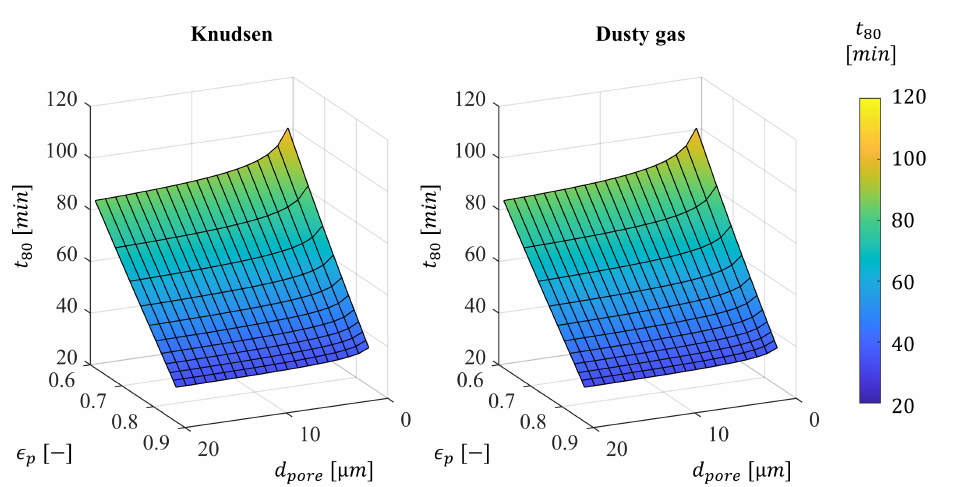
Figure 5. Primary drying time as a function of mean pore diameter and porosity, modeled by Knudsen diffusion and the dusty gas approach for the mass transfer processes through pores in the dried layer. To understand the impact of the porosity on the heat and mass transfer mechanisms, the sublimation flow of water vapor needs to be considered to remove the influence of the decreasing water content, as shown in Figure 6. Here, only the dependency of the drying kinetics on pore volume and conductivity is considered.